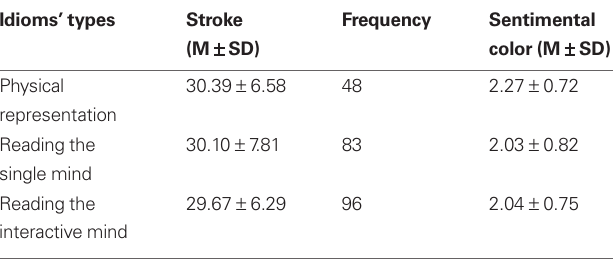
Table 1 | Lexical–statistical properties for three types of Chinese